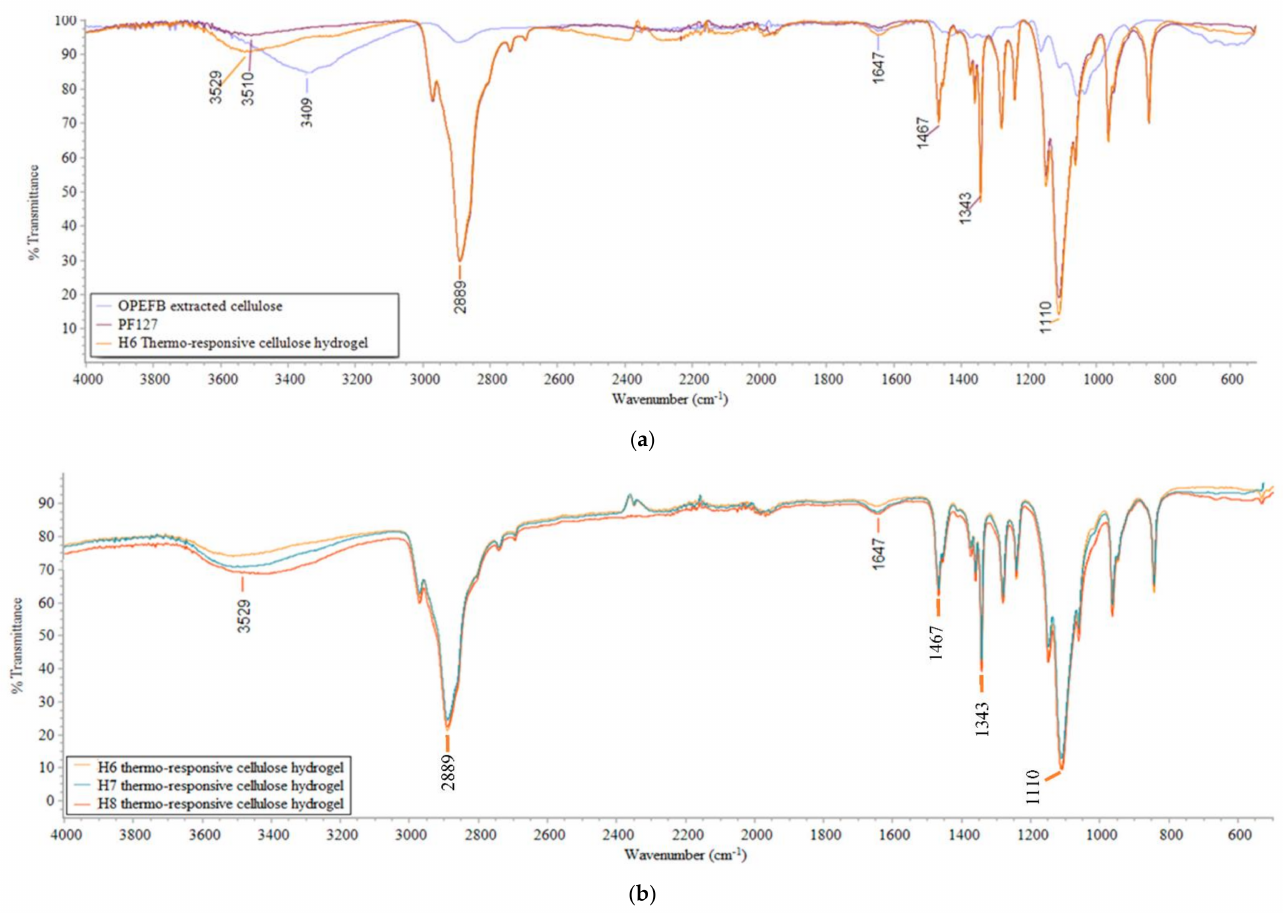
Figure 2. FTIR spectrum of ( a ) OPEFB extracted cellulose, PF127, H6 thermo-responsive cellulose hydrogel ( b ) H6-H8 thermo-responsive cellulose